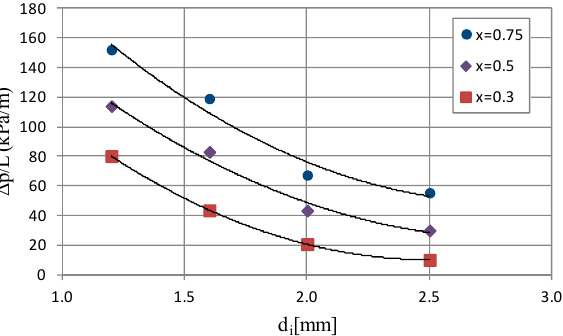
Figure 11. Dependence of heat transfer coefficient on mass flux density G for minchannels with internal diameter: d i = 2.5, 2.0, 1.6 and 1.2 mm (x ≈ 0.5; T s = 39 °C).